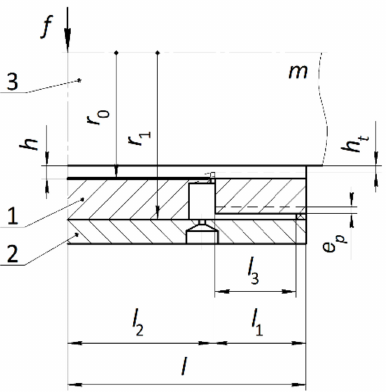
Figure 1. Design diagram of a radial aerostatic bearing.